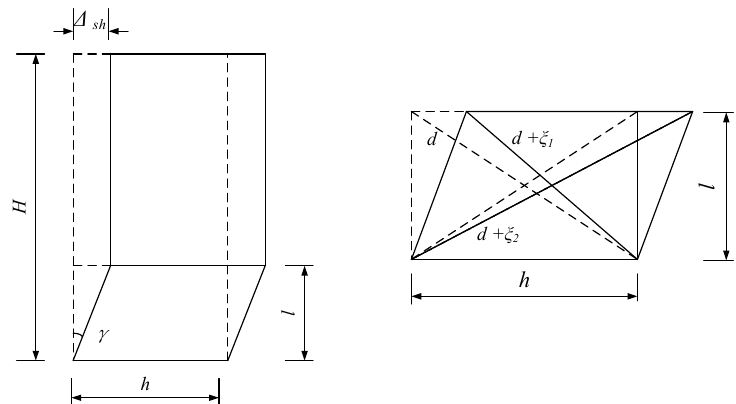
Figure 11. Calculation diagram of shear displacement.